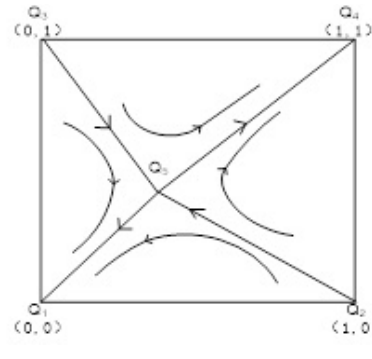
Fig. 3 Phase evolution diagram in scenario